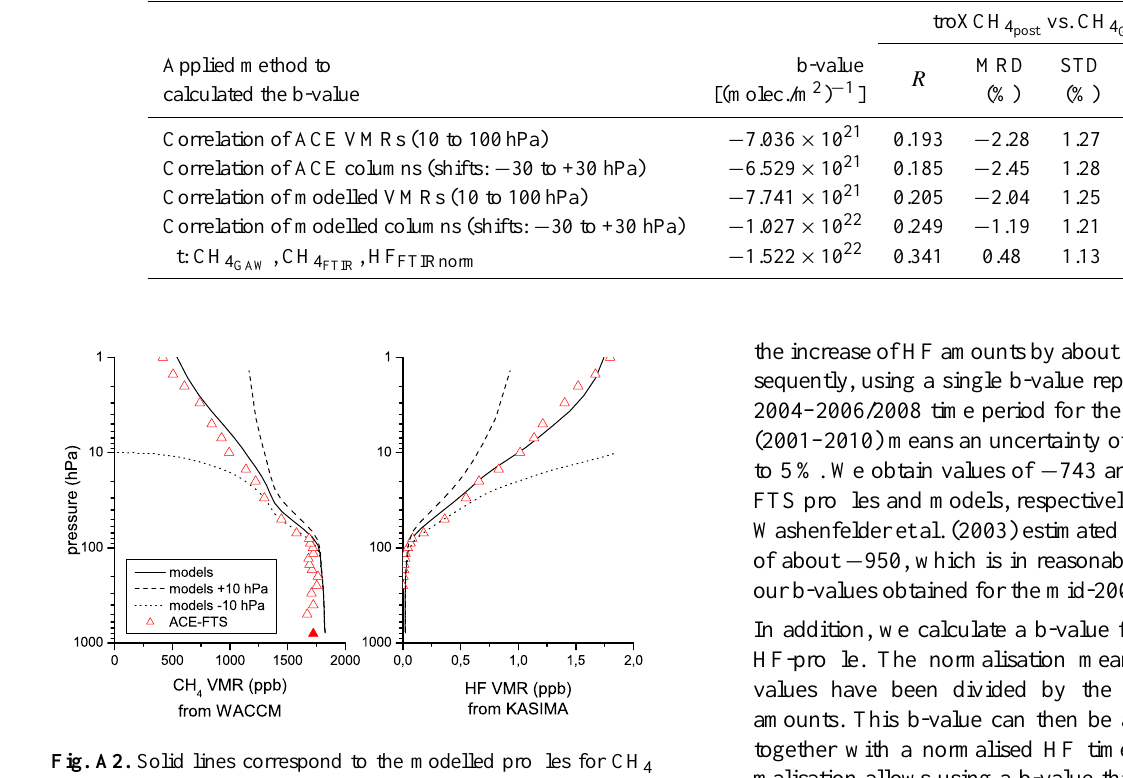
Fig. A2. Solid lines correspond to the modelled profiles for CH 4 (left panel) and HF (right panel). Dotted and dashed lines show the models mixing ratios for − 10 hPa and +10 hPa vertical profile shifts, respectively. Red open triangles show the ACE-FTS mixing ratios (the red filled triangle is the CH 4 concentration that we use for the lower troposphere, where ACE-FTS is not sensitive